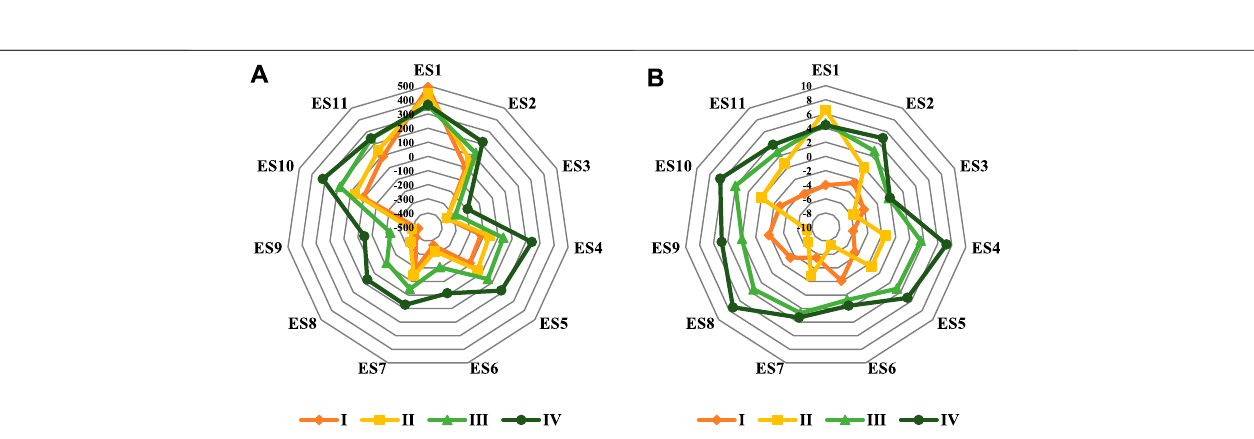
FIGURE 8 | Regionalization of ecosystem service supply and demand at different scales in typical hilly areas, SW China. Left: small scale; right: regional scale.